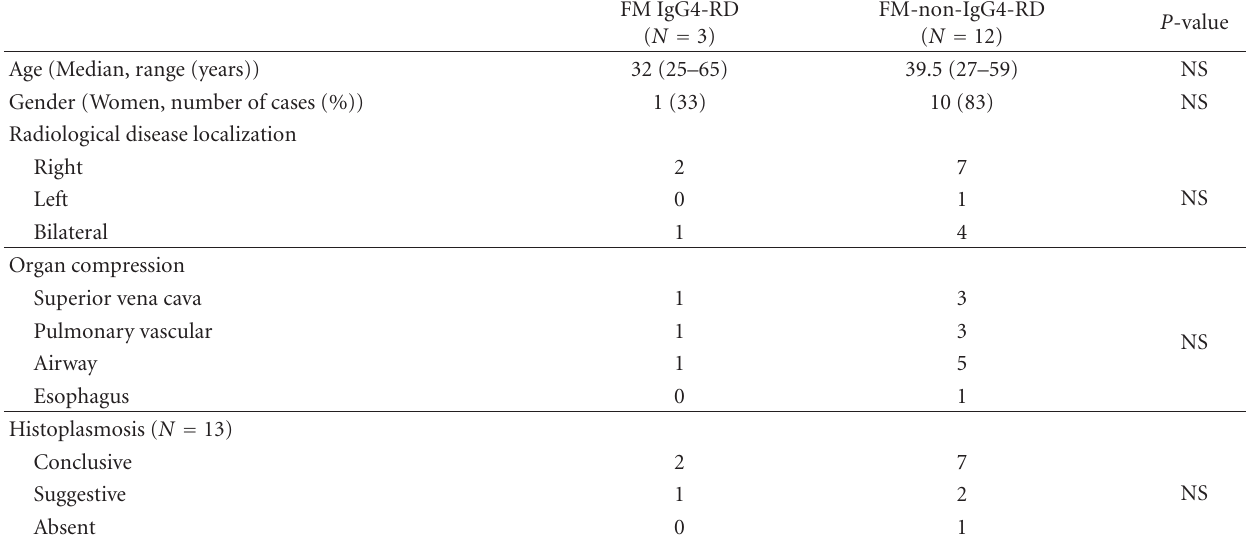
Table 3: Demographic, clinical, and radiological features of FM IgG4-RD and FM-non-IgG4-RD